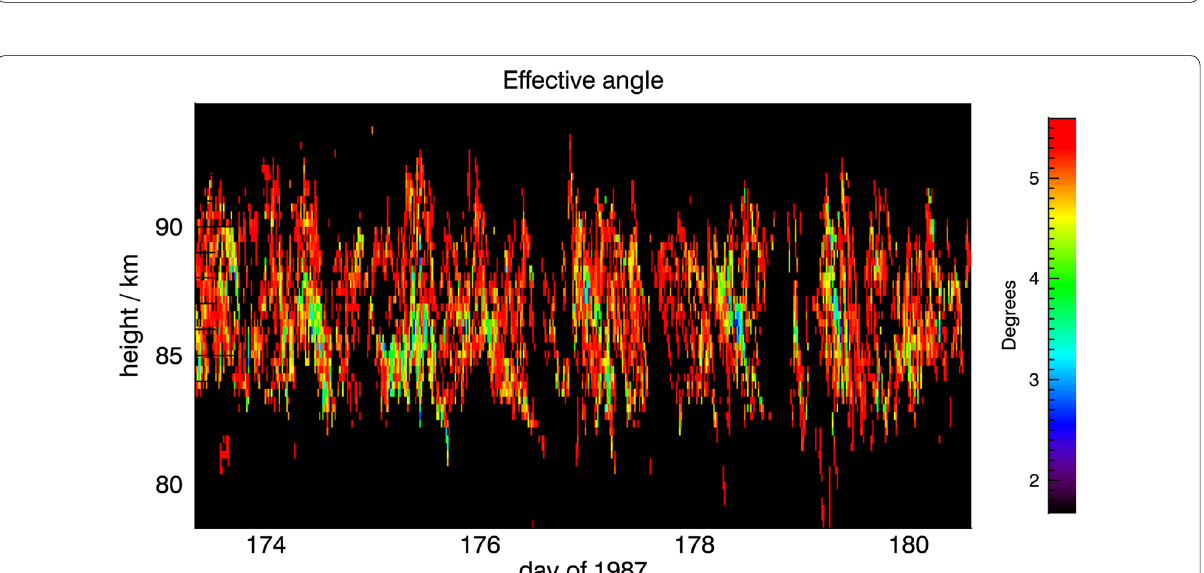
Fig. 3 Scattering angle calculated from 21-min records for the westward beam